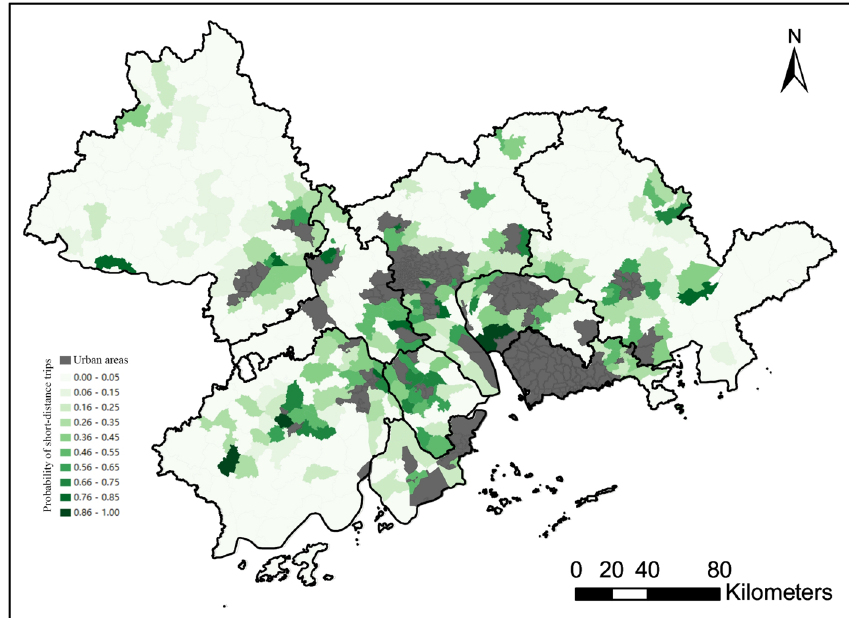
Figure 1. Spatial variation in the relative frequency of short-distance trips across rural towns.